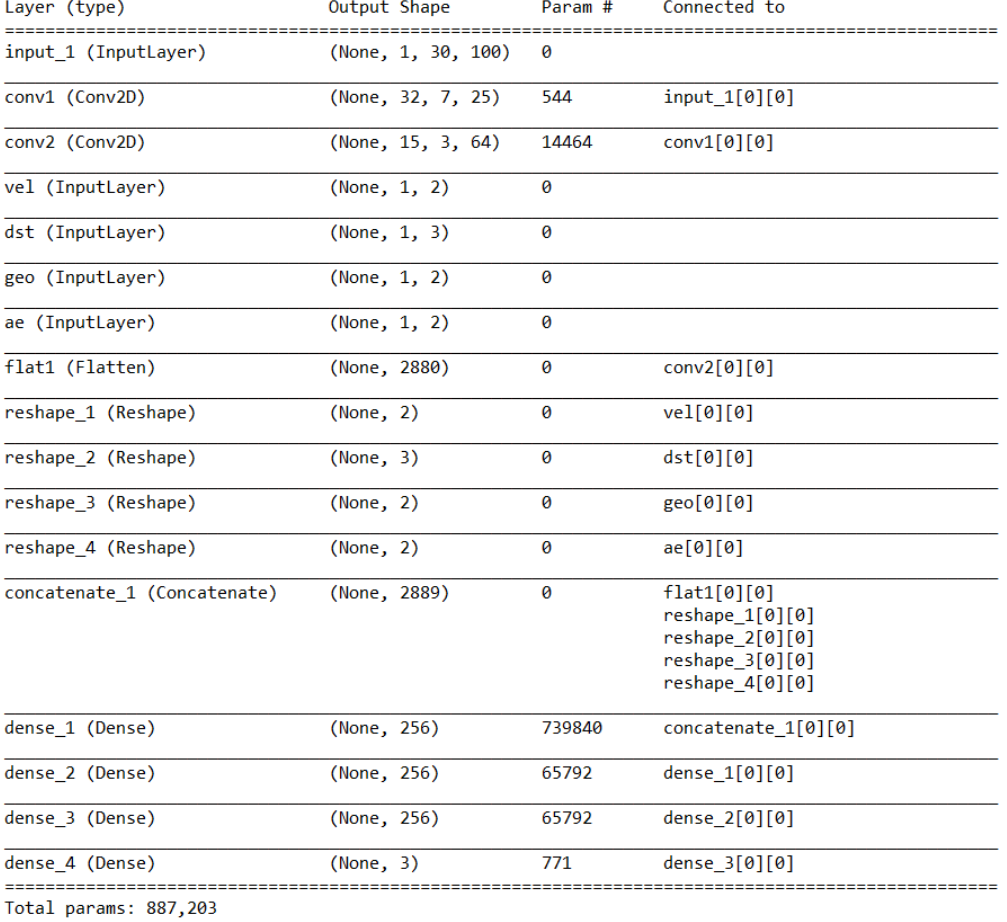
Figure A1. Neural Network Model